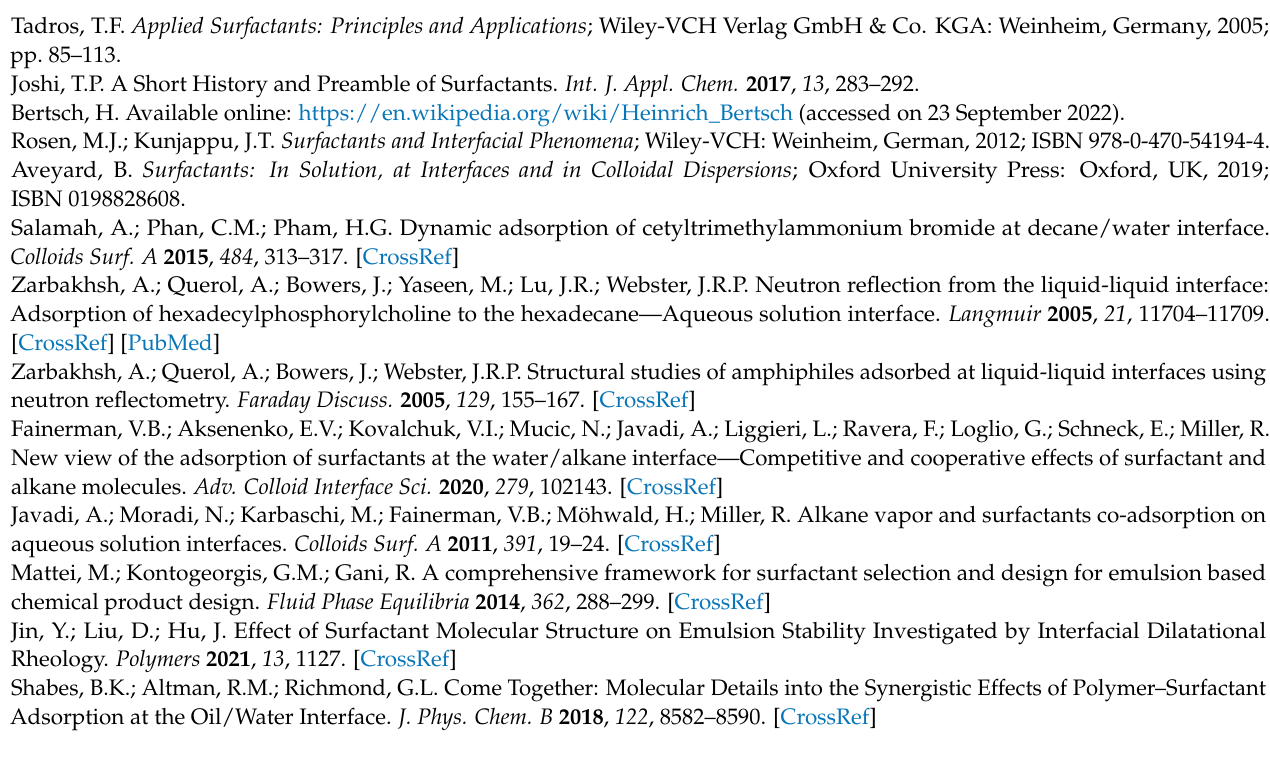
C 14 TAB; Figure S3. C 16 TAB: Figure S4.